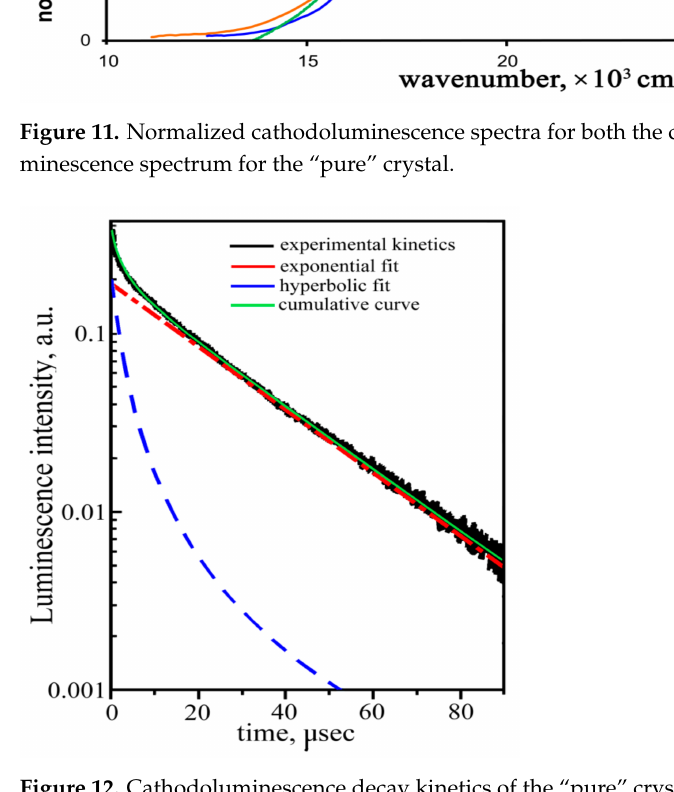
Figure 12. Cathodoluminescence decay kinetics of the “pure”